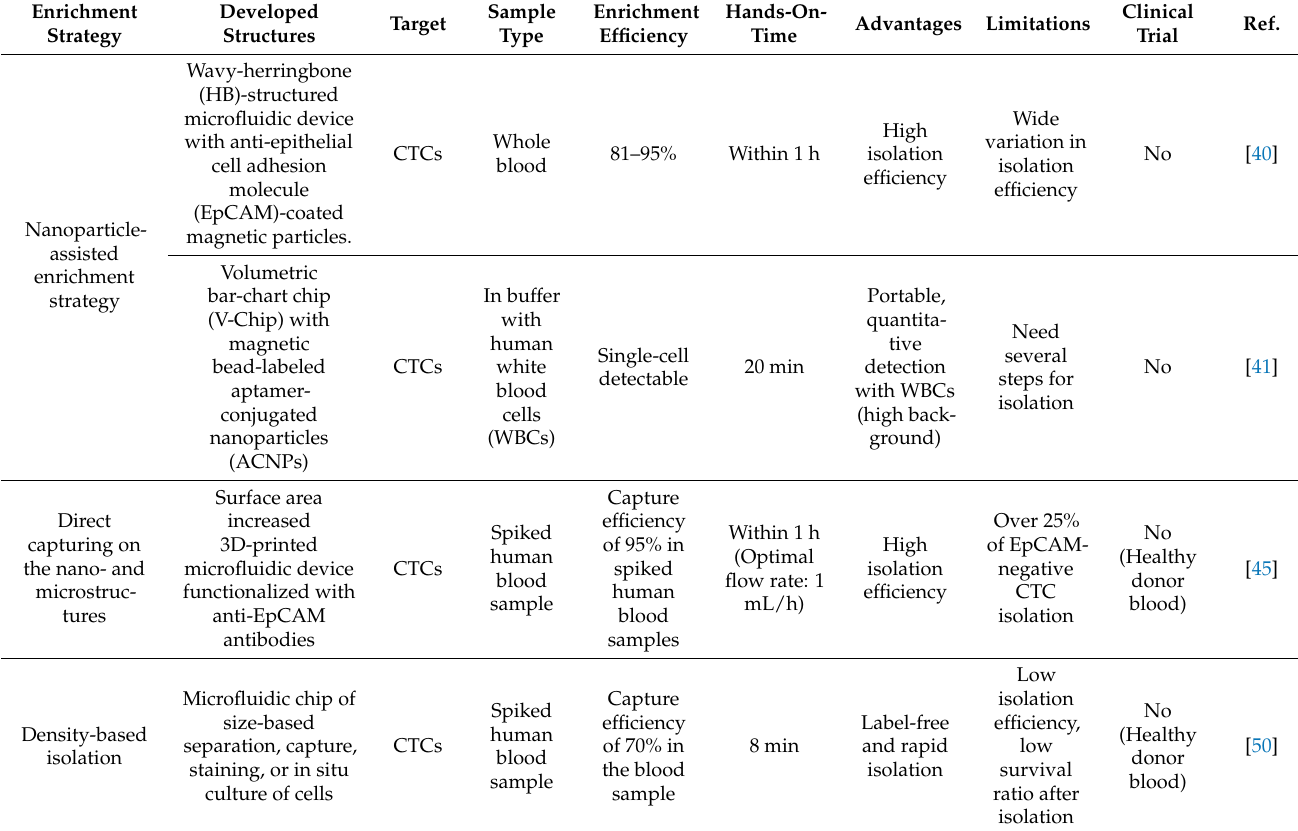
Table 1. Comparison of various strategies for the enrichment of CTCs with their specific structure and enrichment efficiency. Enrichment